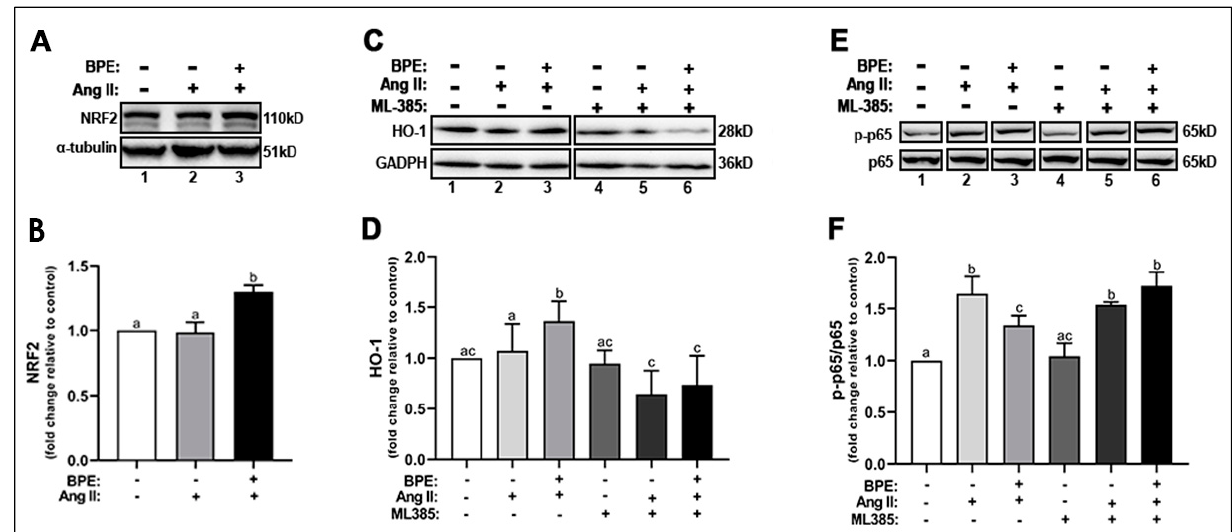
Figure 5. Blueberry polyphenol extract (BPE) increases the expression of NRF2 and HO-1 while reducing NF- κ B p65 phosphorylation in angiotensin (Ang) II-treated human aortic endothelial cells (HAECs). HAECs were treated with 200 µg/mL of BPE for 1 h then treated with 200 nM of Ang II for 12 h. Protein expression of NRF2 ( A , B ), HO-1 ( C , D ), and NF- κ B p65 ( E , F ) were determined by Western blot. Quantification was performed using Image Lab (Bio-Rad Laboratories, Inc.). Data are expressed as mean ± SD from nine (HO-1), and three (NRF2 and NF- κ B) independent experiments. Values that do not share the same letter are significantly different from each other ( p ≤ 0.05).